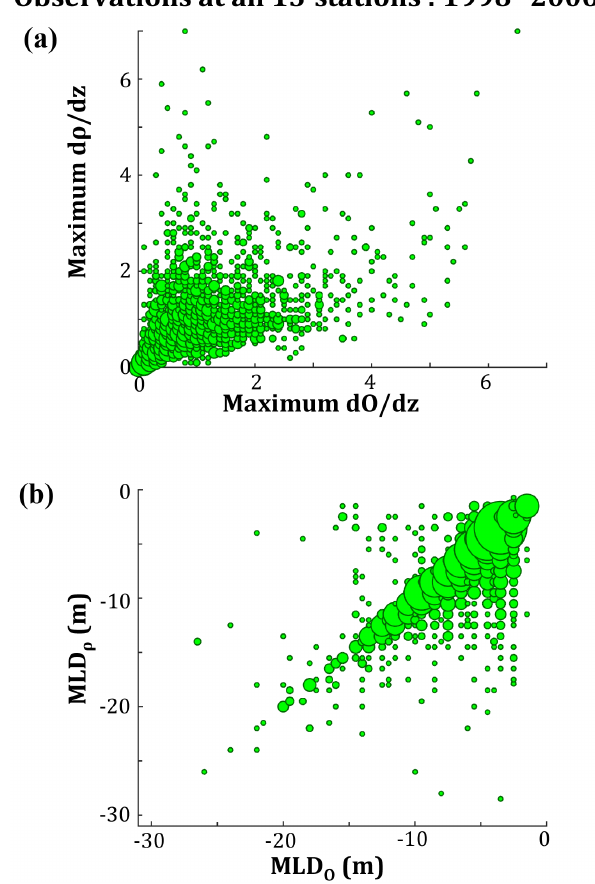
Figure 10. Scatter plots comparing observations of (a) the strengths of stratification of the pycnocline and oxycline and (b) the oxygen- and density-defined mixed layer depths. Size of the circles is pro- portional to the number of observations. Observations are from 1998 to 2006 at the 13 Chesapeake Bay stations shown in Fig.